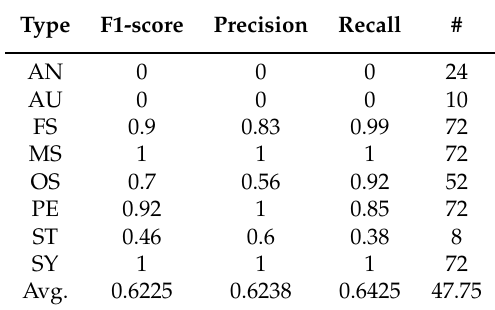
Table 5. Manual model 1 (the original data).